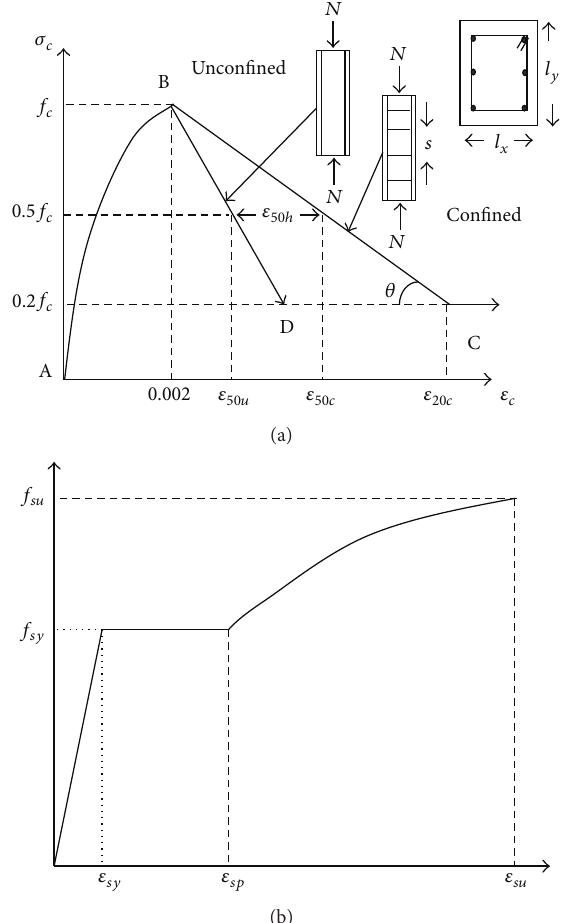
Figure 4: (a) Stress-strain relation of reinforced concrete [5]. (b) Stress-strain relation of steel bars